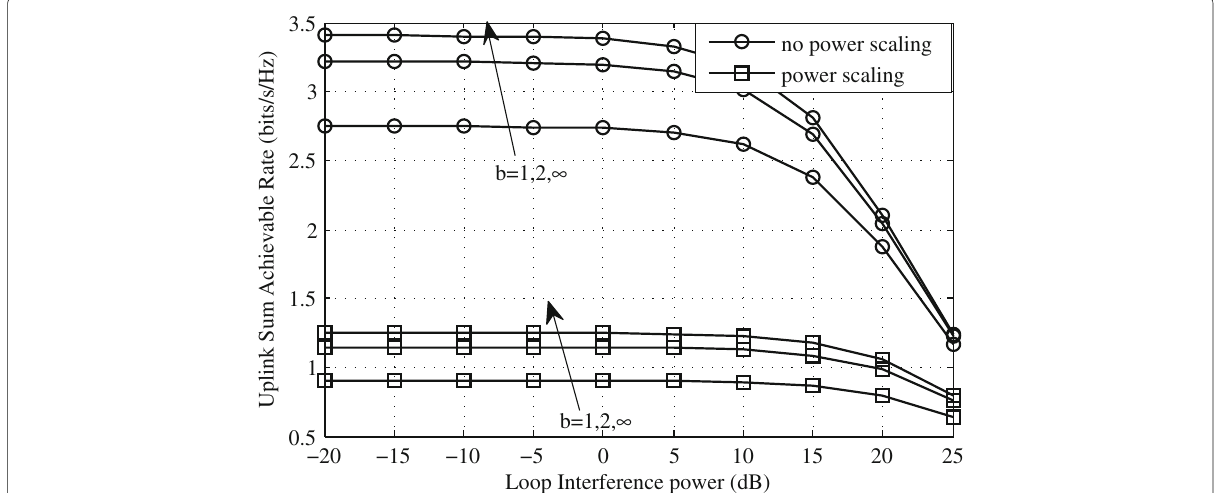
Fig. 3 Uplink sum achievable rate for power scaling and no power scaling. Comparison of uplink sum rate for the different numbers of quantization bits b versus the residual LI power ημ